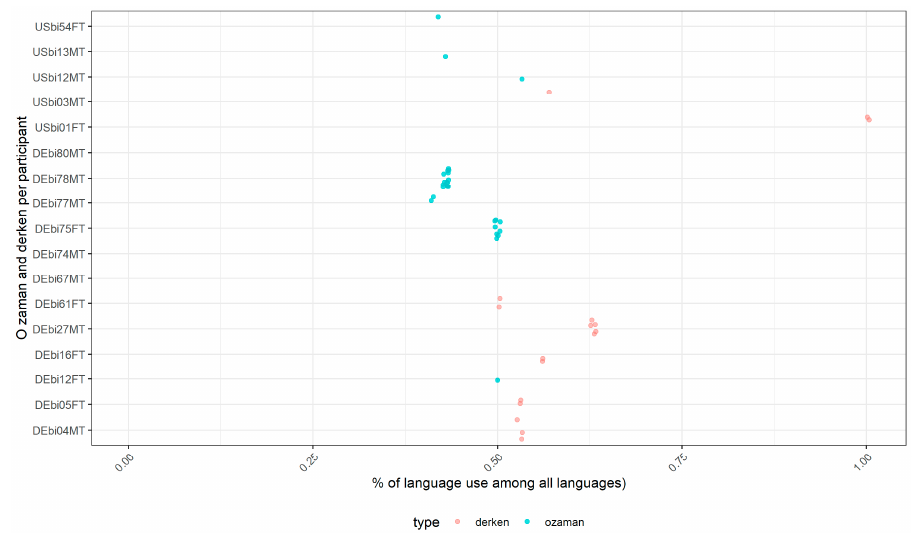
Figure A1. Jitter plot showing the total % of Turkish language use per participant regarding their uses of o zaman and derken.